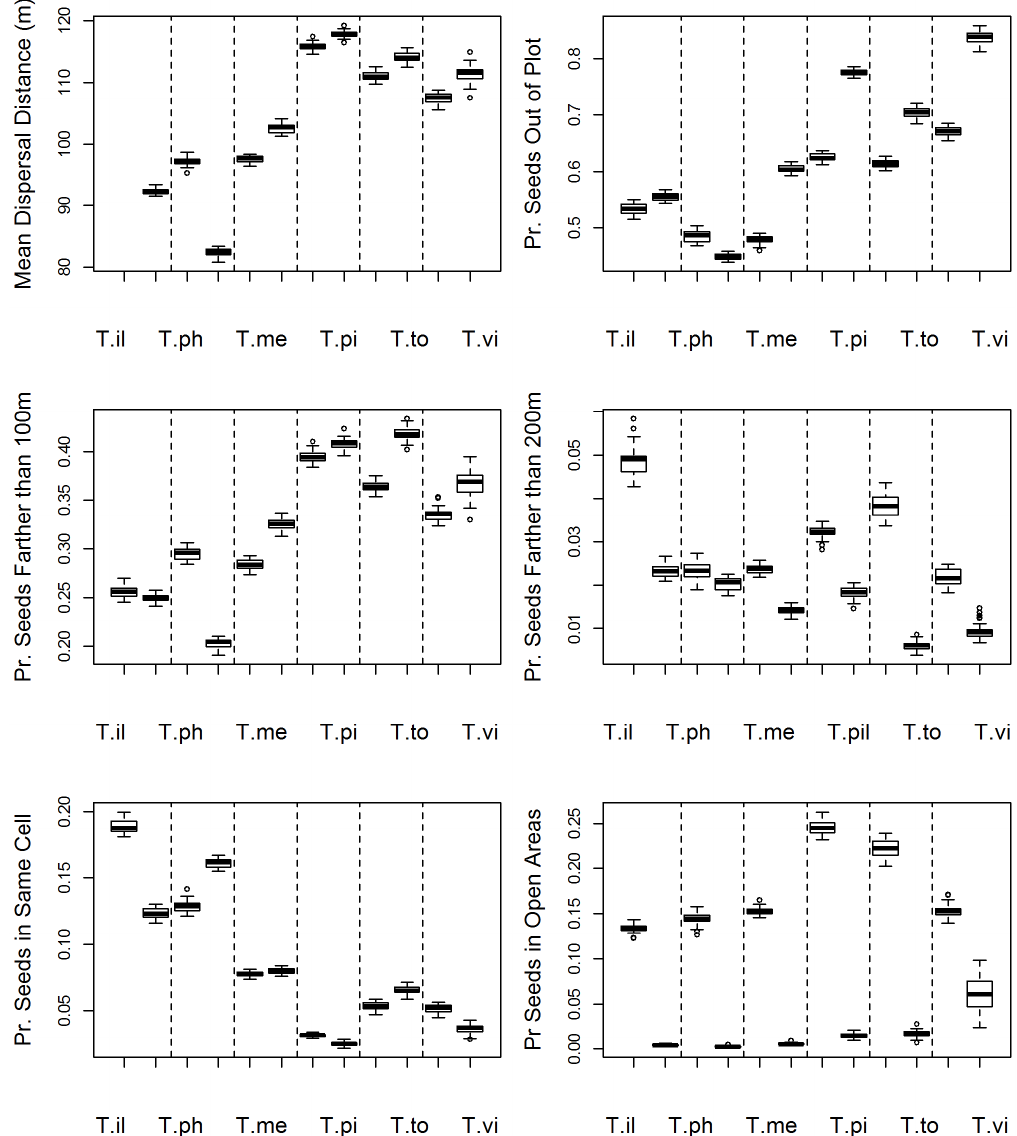
Figure 2. Distance properties of seed shadows by different Turdus species. Every pair of boxplots within dashed lines corresponds to the results from 30 replicate model runs for a particular Turdus species. The first box is for a ‘‘distance-only’’ model and the second one for the ‘‘full’’ model. When seeds were dispersed out of the study plot, we used as dispersal distance the value just outside the nearest edge. Bird species are T. iliacus (T. il), T. philomelos (T. ph), T. merula (T. me), T. pilaris (T.pi), T. torquatus (T. to) and T. viscivorus (T.